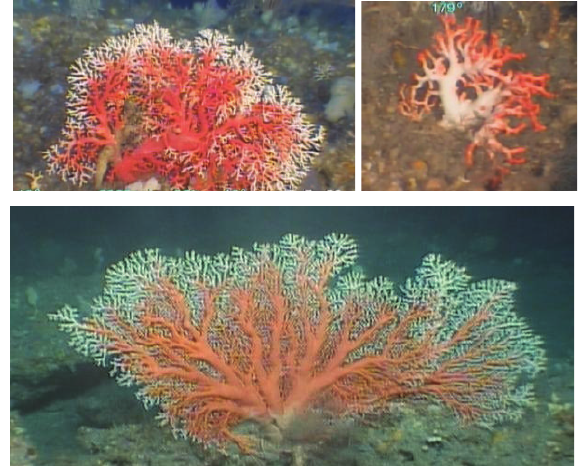
Figure 2: Commercial species of precious corals from Japan. Above left: Paracorallium japonicum (Kishinouye, 1903). Above right: Corallium konojoi Kishinouye, 1903. Below: Corallium elatius (Ridley,